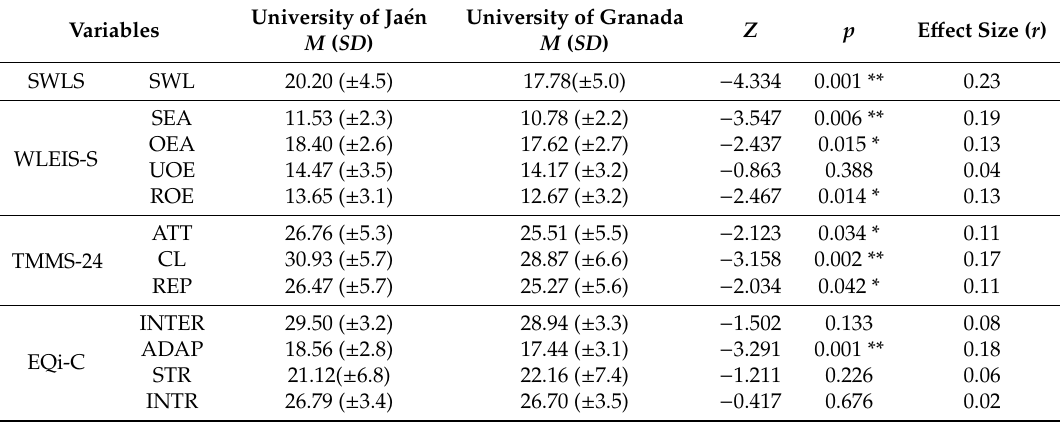
Table 3. Mean di ff erences according to the University (U of